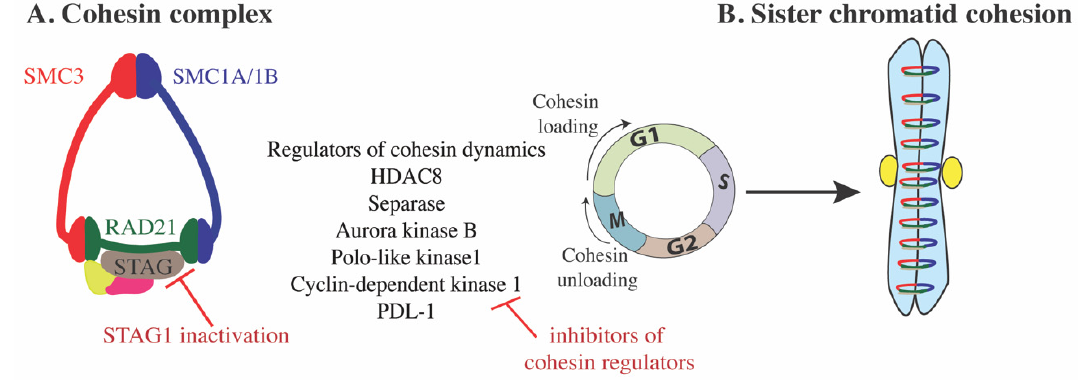
Figure 1. ( A ) Schematic of the cohesin complex. Cohesin loading and unloading onto chromosomes during cell cycle is dynamic and involves a number of regulators. STAG2 mutations are the most frequent, and inhibition of STAG1 subunit is synthetically lethal with STAG2 mutations. Listed are the cohesin regulators that can be pharmacologically inhibited and their inhibition mainly disrupts cell cycle progression. ( B ) Cohesin subunit SMC3 acetylation during S phase ensures sister chromatid cohesion.